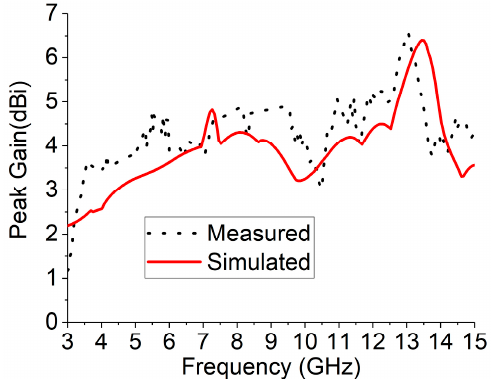
Figure 11. The simulated and measured gain of the antenna.